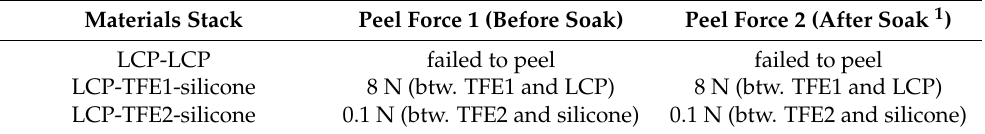
Table 2. Peel force required to compromise the adhesion inside each material stack under test.